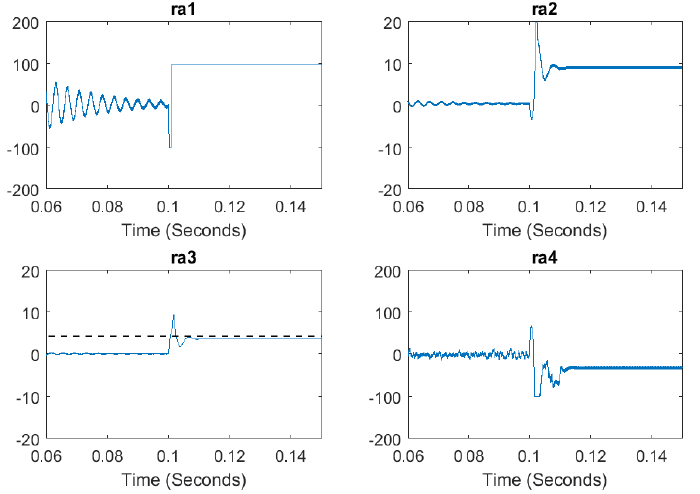
Figure 19. Simulation of residuals in the case of a photovoltaic panel fault.